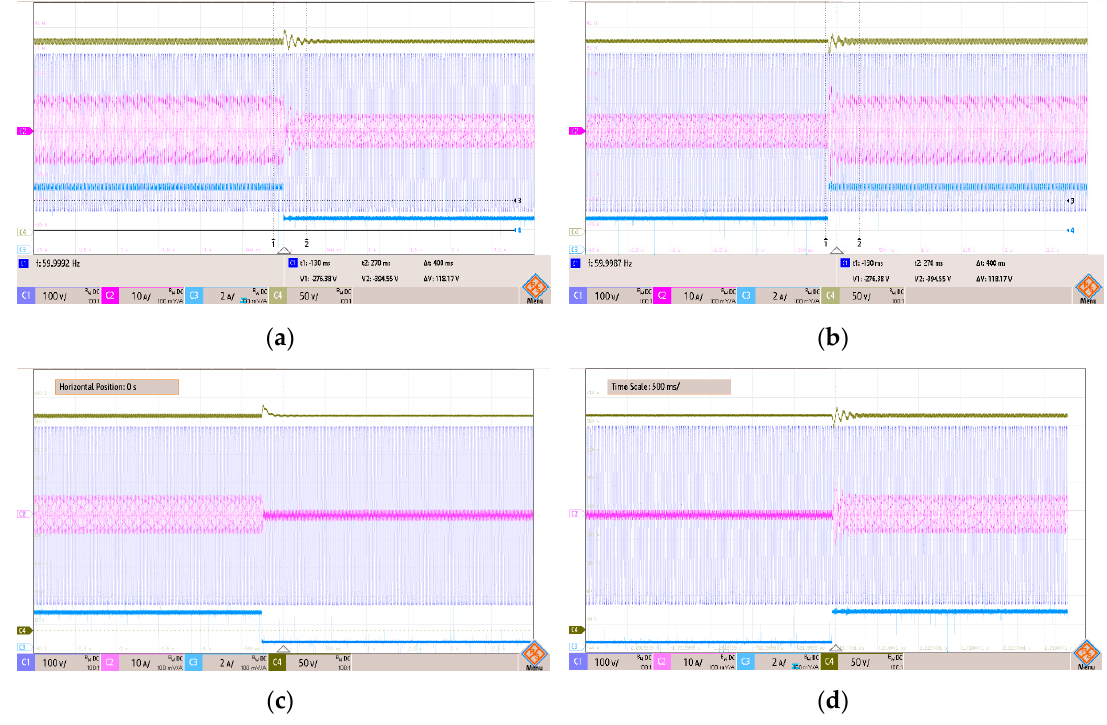
Figure 11. Measurement result of the transient response ( a ) from 100 to 50 percent load; ( b ) from 50 to 100 percent load; ( c ) from 50 to 0 percent load; (d) from 0 to 50 percent load. (for all figures: V AC 100 V/division, channel 1– I L 10 A/division, channel 2– V OUT 50 V/division, channel 3– I OUT 2 A/division,